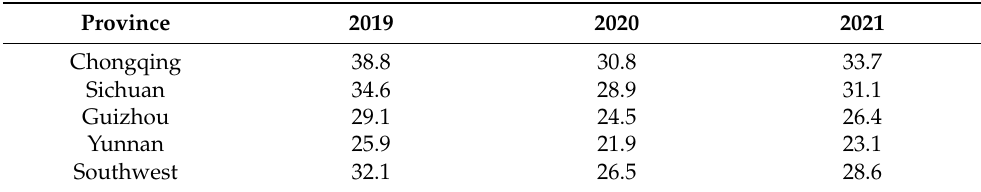
Figure 5. Annual change in PM 2.5 spatial distribution in southwest China. As shown in Table 3, the average PM 2.5 concentration in 2020 was significantly lower than that in 2019; the concentration increased in 2021, with the average values being 32.1, 26.5, and 28.6 µ g/m 3 for 2019, 2020, and 2021, respectively; all these values were lower than the annual average limit level 2 standard. From the perspective of provinces and cities, the values for four provinces and cities in 2020 all decreased by more than 15% as compared with those in 2019. Chongqing had the largest decline of 20.7%, and Sichuan, Guizhou, and Yunnan showed a decrease of 16.4%, 15.7%, and 15.4%, respectively. In comparison with 2020, 2021 showed an increase of about 5–10%, where the value in Chongqing increased by 9.6% (the largest increase) and that in Guizhou Province, Sichuan Province, and Yunnan Province increased by 8.0%, 7.6%, and 5.5%, respectively. Considering the overall change trend, PM 2.5 concentration significantly decreased from the beginning of the COVID-19 pandemic in 2020, but began to rise after the relaxation of pandemic control measures in 2021. Table 3. Annual variation in PM 2.5 concentration in provinces and cities in southwest China (Unit: µ g/m 3